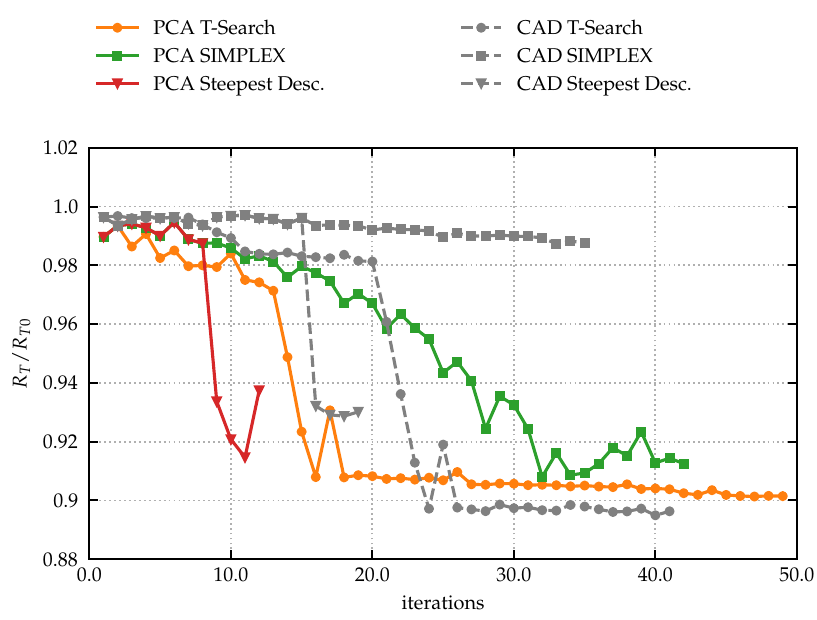
Figure 18. Evaluation of objective function with XPAN for three optimisation algorithms applied in CAD space and PCA space.